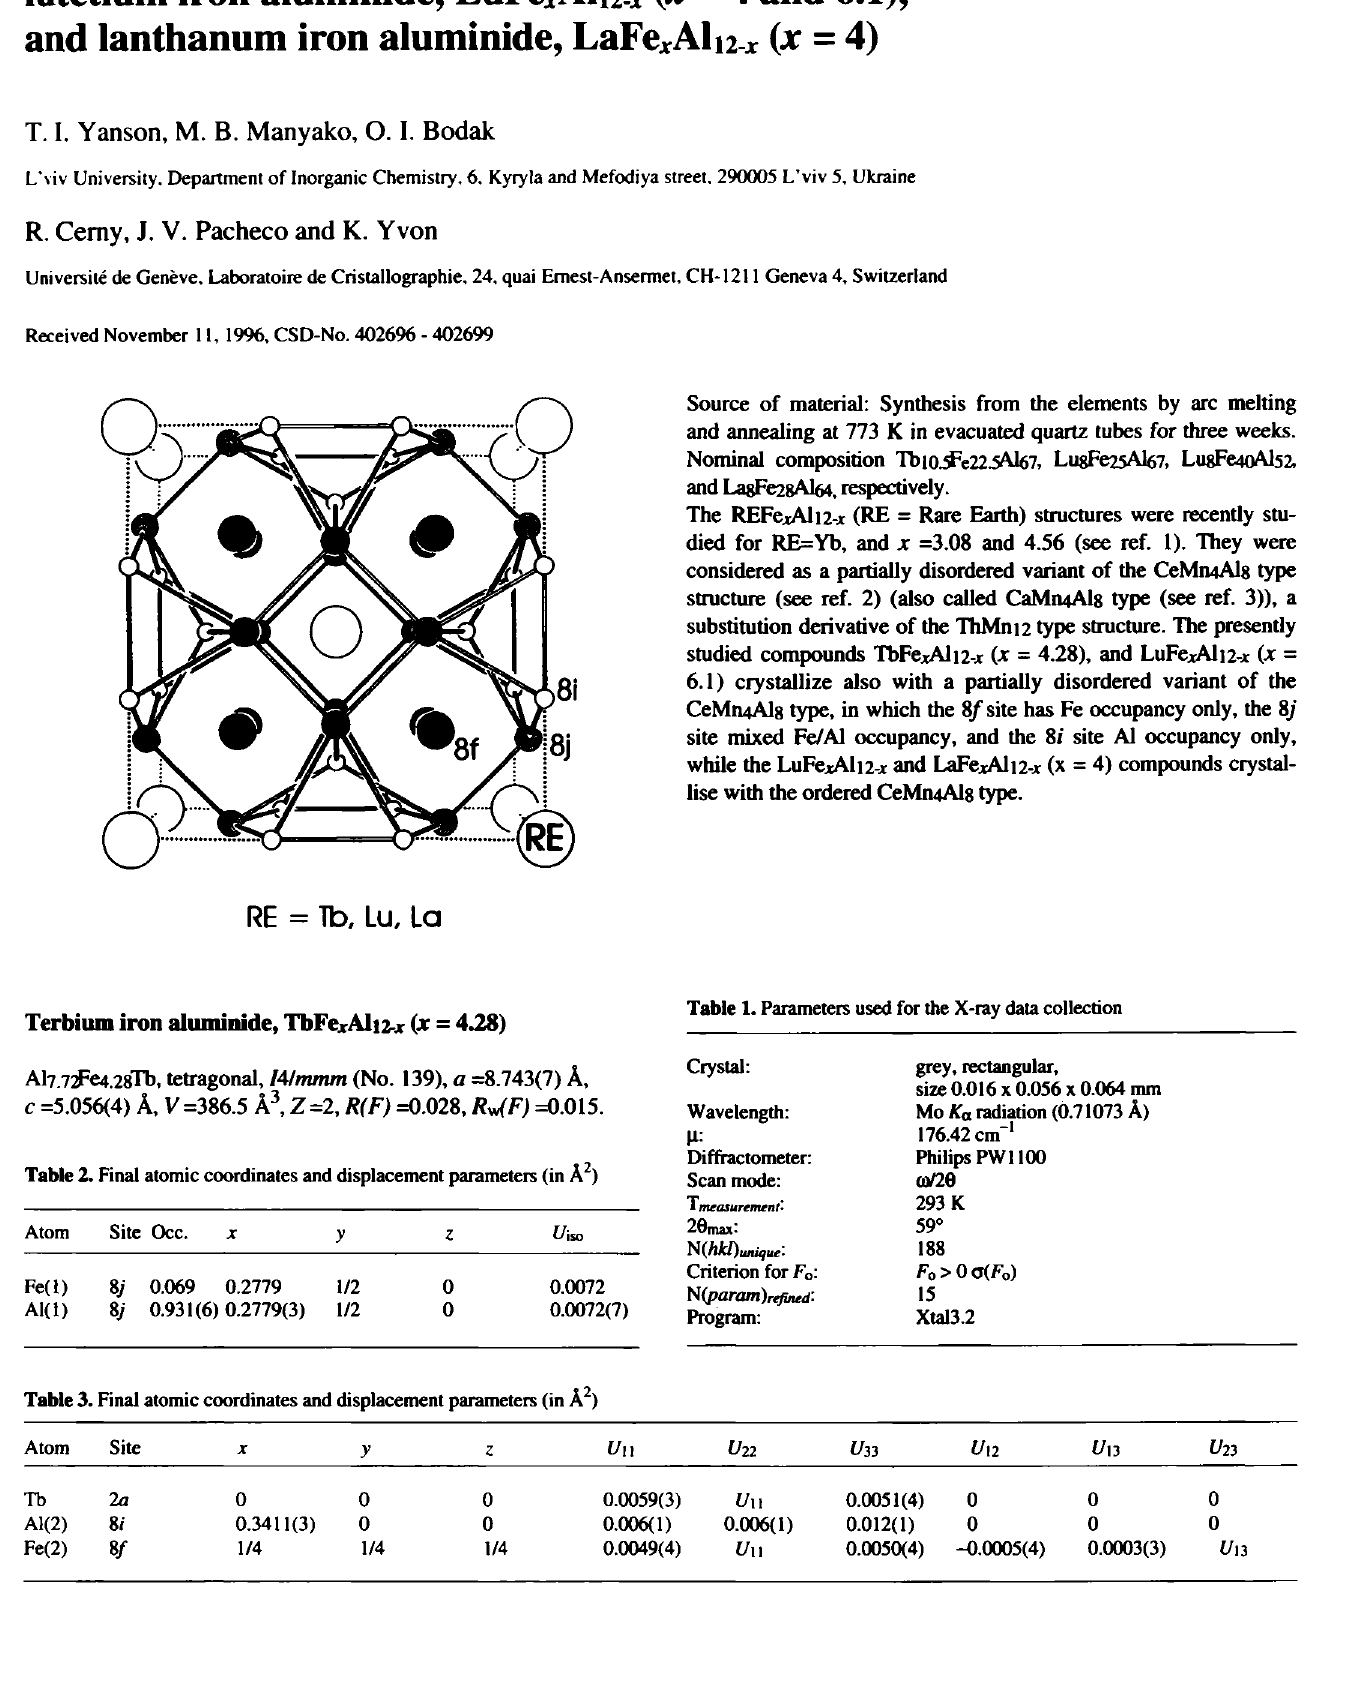
Table 3. Final atomic coordinates and displacement parameters (in Â 2 ) Atom